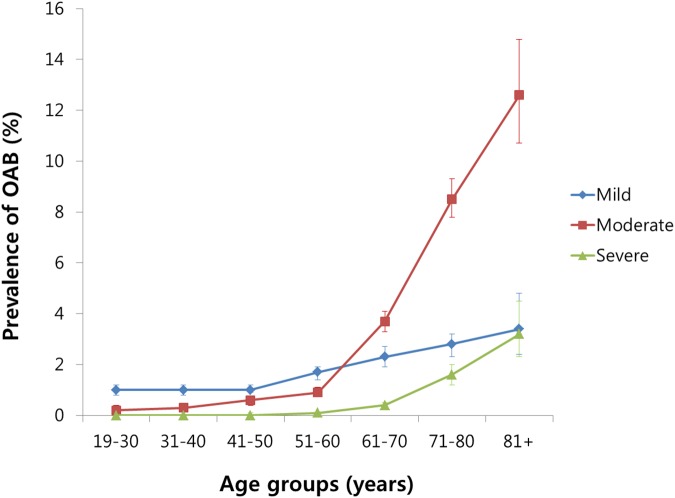
The prevalence of OAB according to age group.